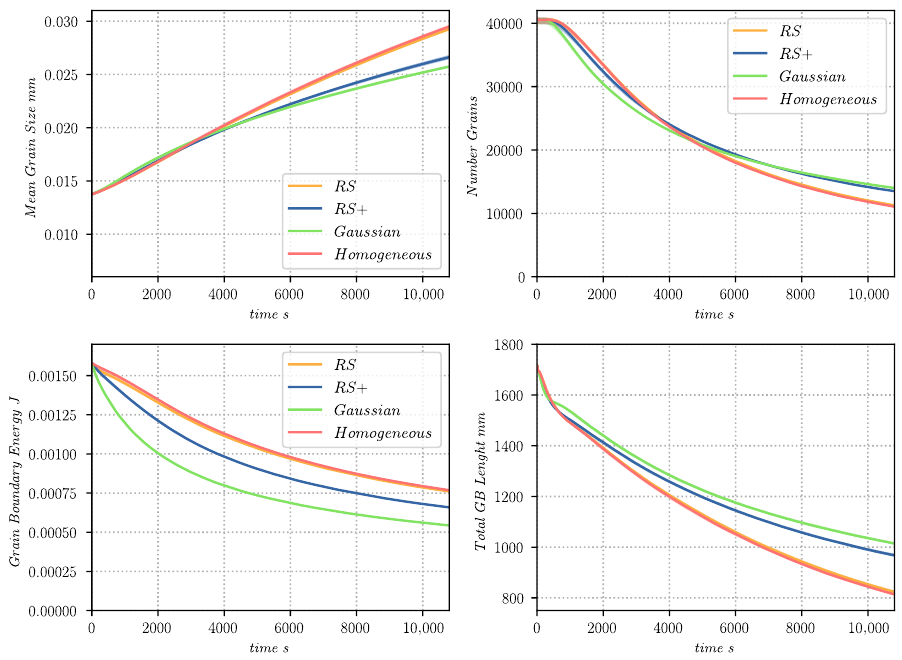
Figure 13. Evolution of different parameters as a function of time, for the 2D heterogeneous GG test case simulated with the TRM model: ( top-left ) mean grain size pondered by surface, ( top-right ) number of grains, ( bottom-left ) total grain boundary energy E Γ and ( bottom-right ) total lenght of